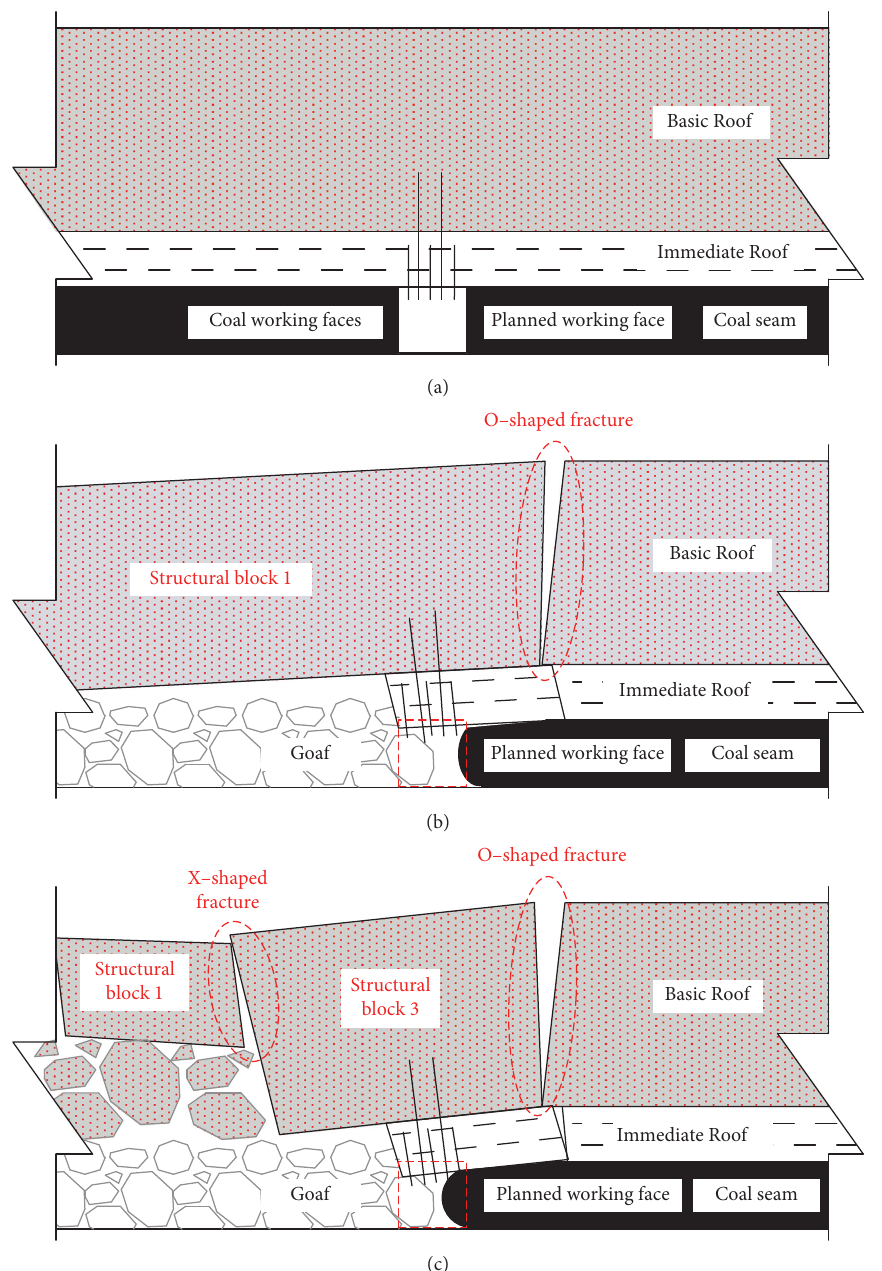
Figure 3: Fracture characteristics of roadway roof. (a) Roof structure before mining in working face. (b) O-shaped fracture of roof after mining. (c) X-shaped roof fracture after